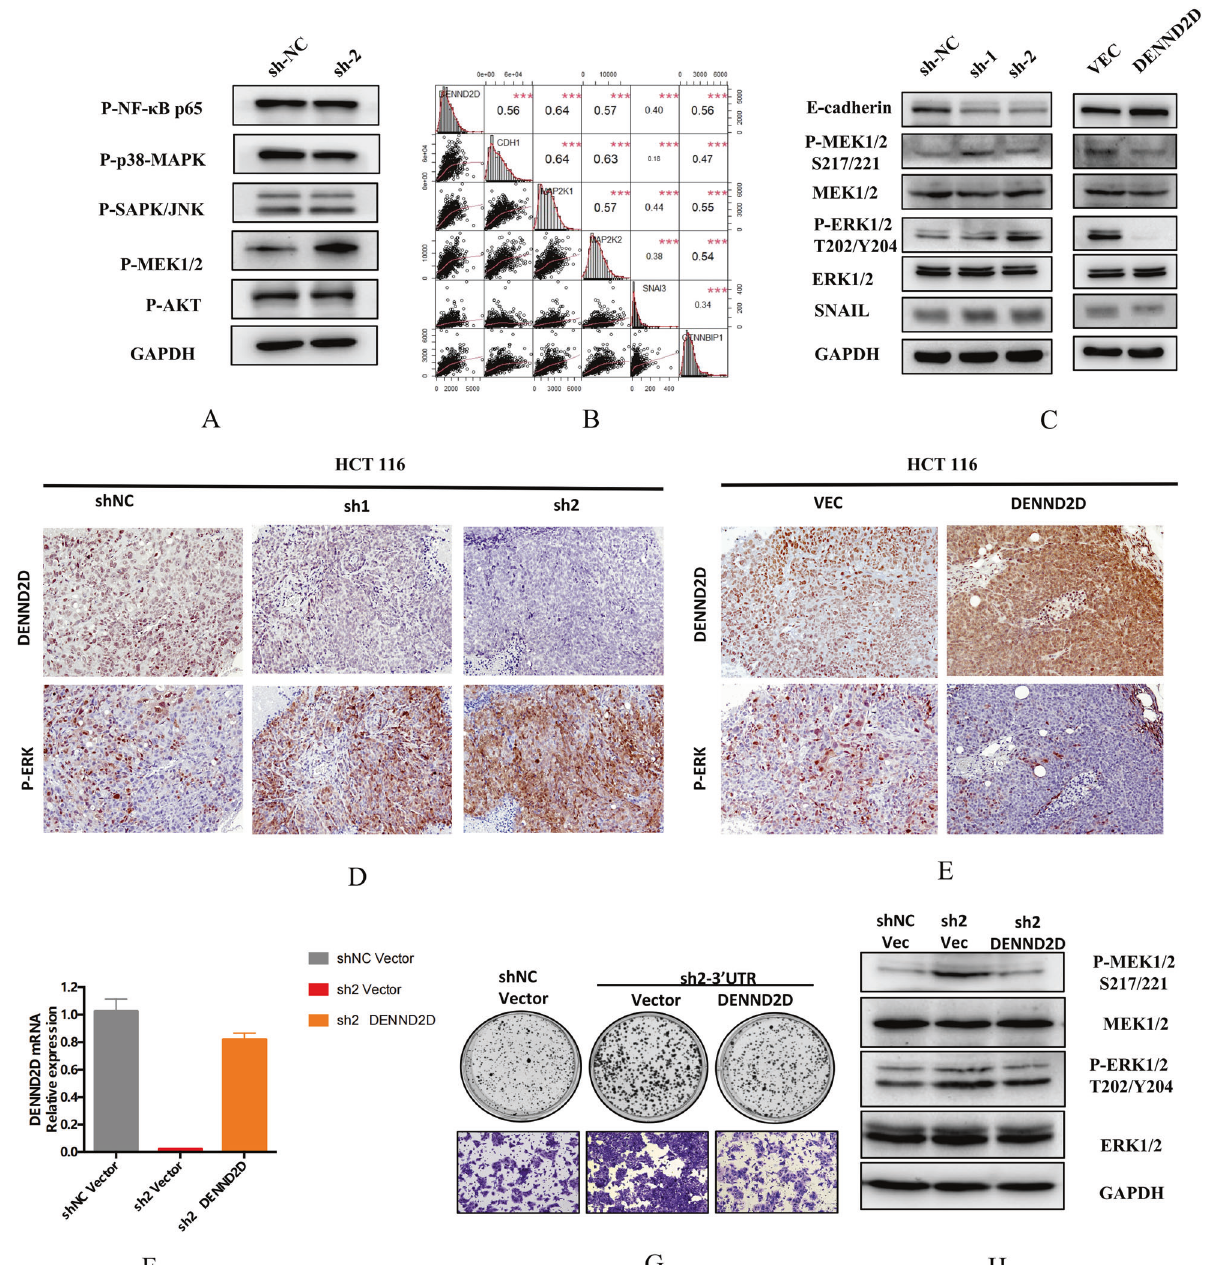
Fig. 5 DENND2D suppressed CRC cell proliferation and metastasis in vitro by MAPK pathway. A Differential pathway-related protein expression between shNC and sh2 DENND2D cell lines. B The relationship between six key molecules using Pearson correlation analysis of the data from the TCGA database. C DENND2D overexpression or knockdown changed the levels of p-MET1/2 (Ser221) and p-ERK1/2 (Thr202/ Tyr204) in HCT116 cells, as determined by WB assay. D , E DENND2D and pERK were expressed in xenografts generated from HCT116-sh1/sh2, HCT-shNC, HCT116, and DENND2D-overexpressing cells. F – H Restoring DENND2D expression in DENND2D-silenced CRC cells rescued the activity of the MAPK